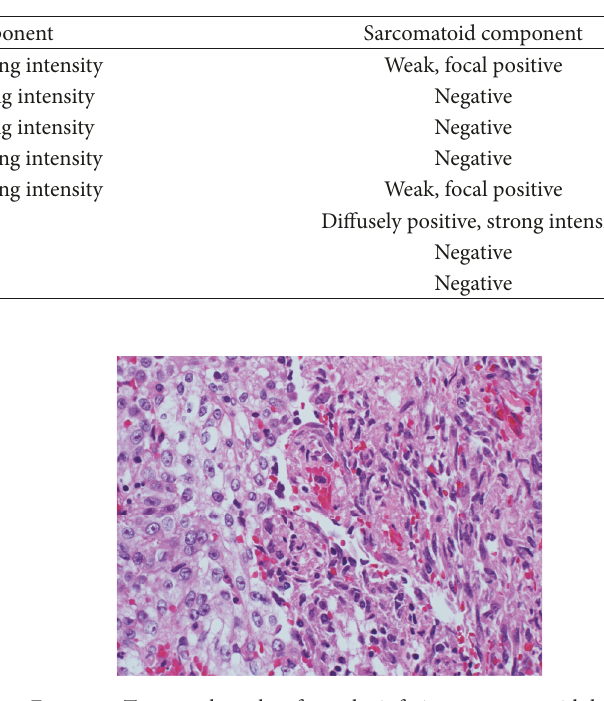
Figure 7: Tumour thrombus from the inferior vena cava with high grade urothelial carcinoma and the sarcomatoid